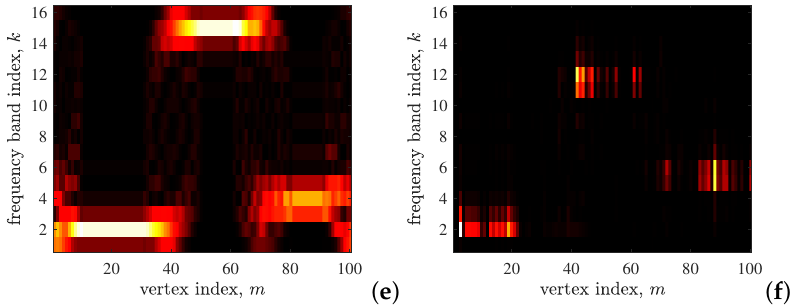
Figure 17. ( a ) Time–frequency analysis of the harmonic signal from Example 1, shown in Figure 3 (top), using the polynomial approximations of transfer functions from Figure 14b. ( b ) Vertex–frequency analysis of the general graph signal from Example 1, shown in Figure 3 (bottom), using the transfer functions from Figure 14b. ( c ) Time–frequency analysis of the harmonic complex signal from Example 1, using the transfer functions from Figure 14c. ( d ) Vertex–frequency analysis of the general graph signal from Example 1, using the transfer functions from Figure 14c. ( e ) Time– frequency analysis of the harmonic complex signal from Example 1, using the transfer functions from Figure 14d. ( f ) Vertex–frequency analysis of the general graph signal from Example 1, using the transfer functions from Figure 14d. A complex signal is formed by adding two corresponding sine and cosine